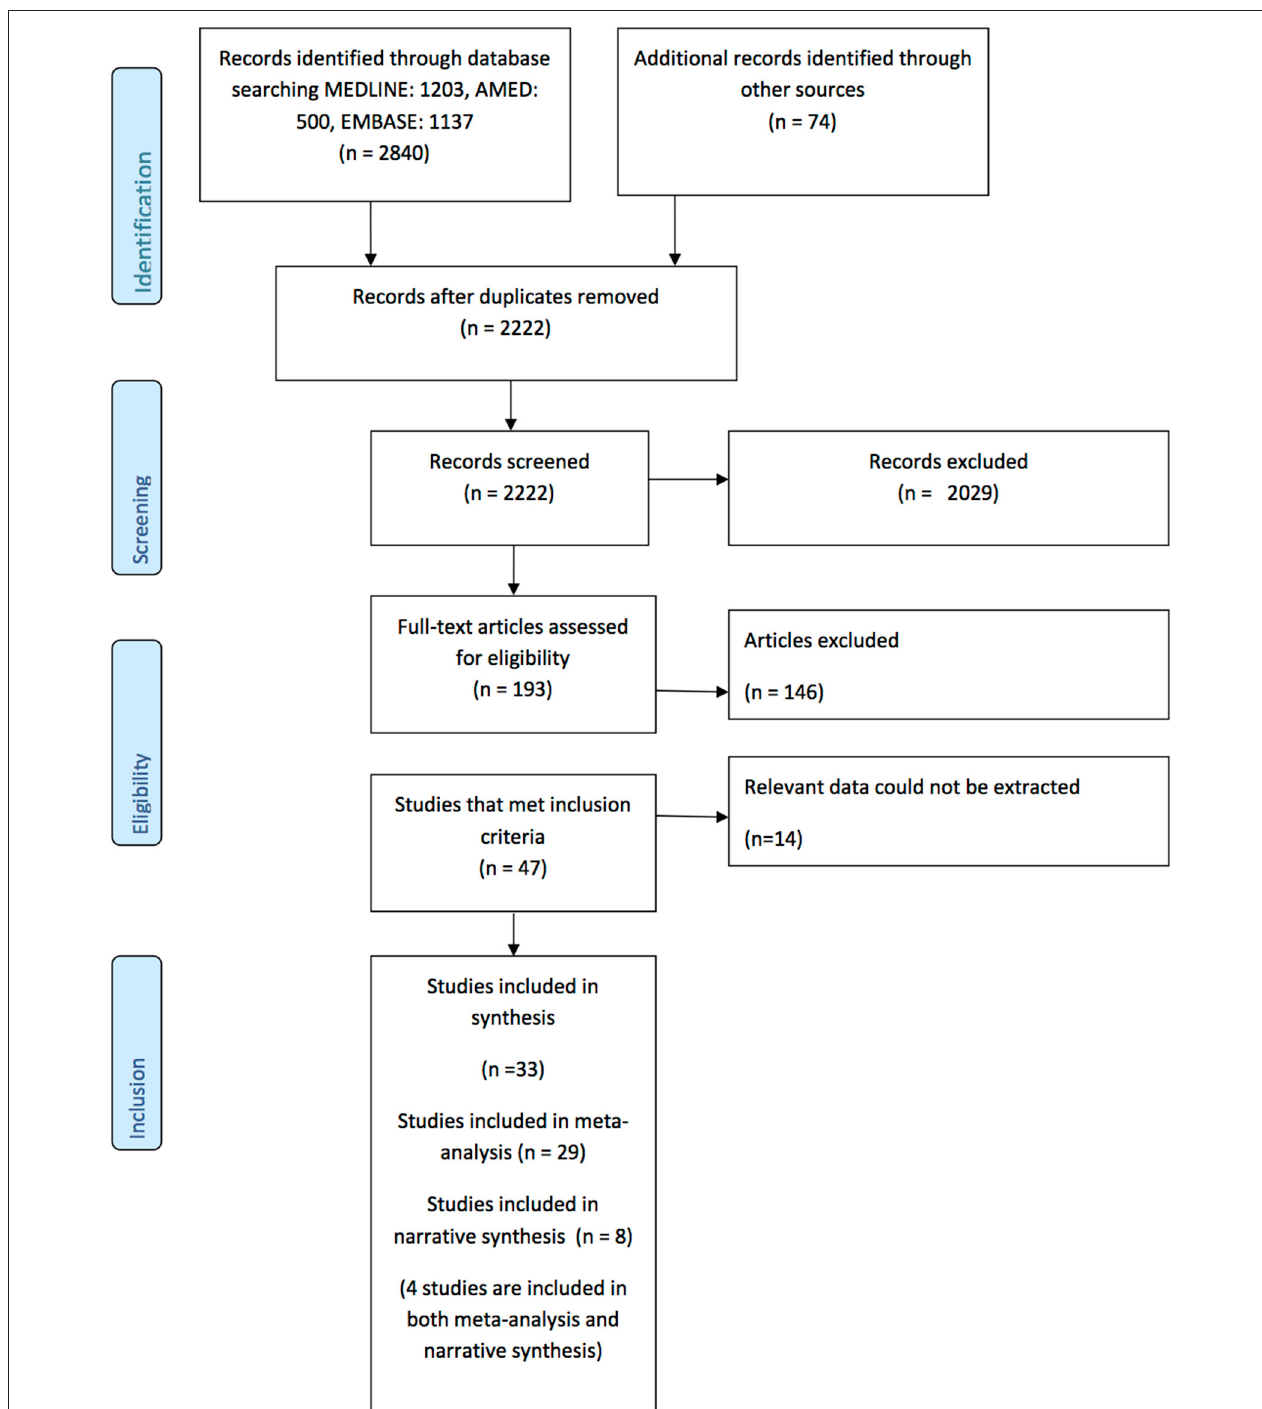
FIGURE 1 | Prisma Diagram detailing the search and processes of identification of studies included in the systematic review.